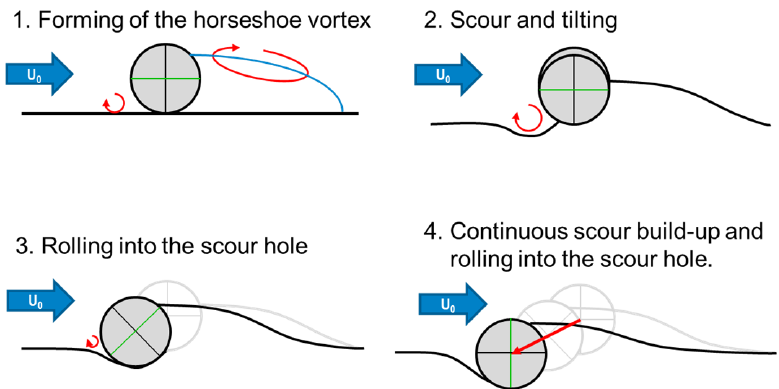
Figure 2. Model of burial of a cylindrical object in constant inflow [6]. Incident current from the left side.